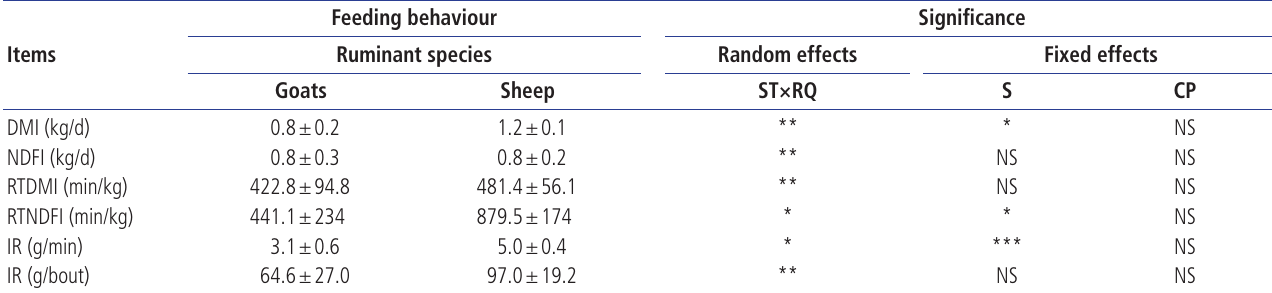
Table 10. Effects of ruminant species on feeding behaviour (LSM±SEM) of sheep and goats fed varying diets and roughage qualities in 6 different studies